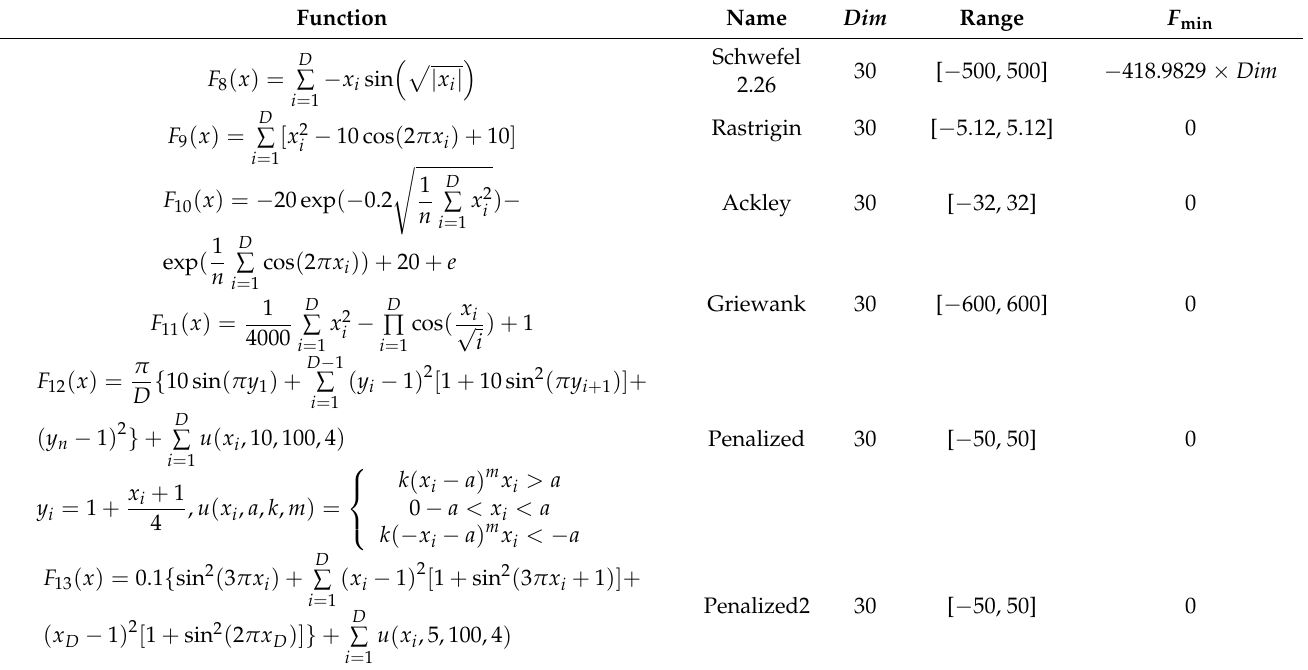
Table 2. Multimodal benchmark function.